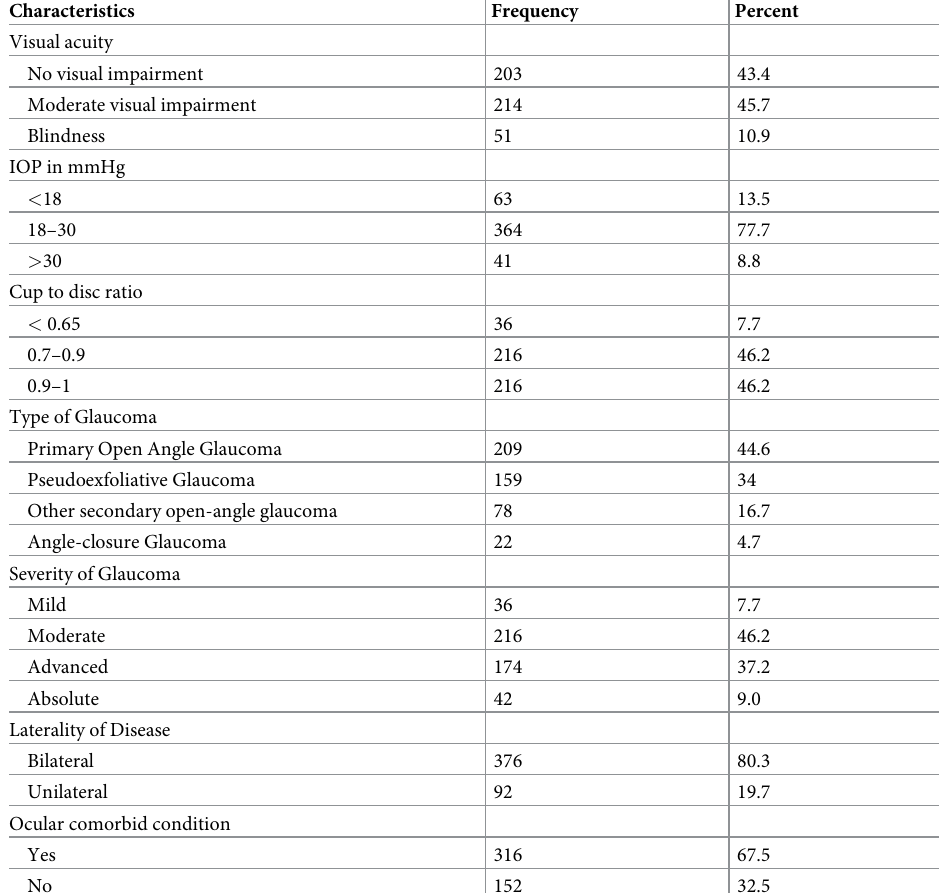
Table 3. Ocular clinical characteristics of study